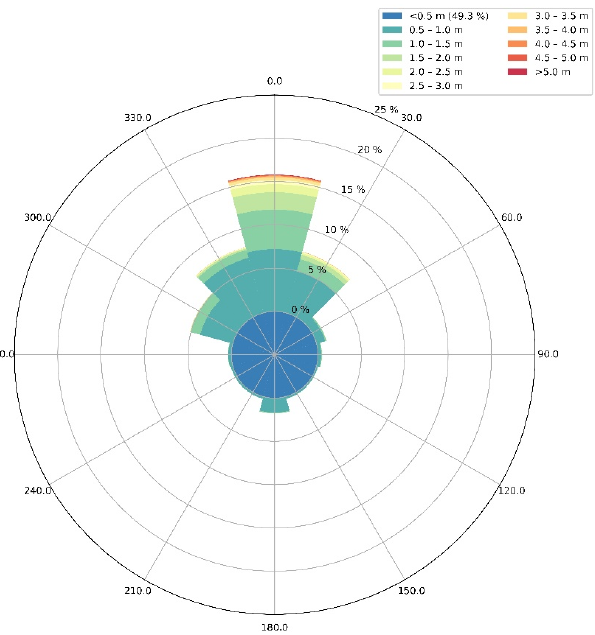
Figure 3. Wave Rose Diagram of Mean Annual Significant Wave Heights, Hs (m), offshore of the Rethymno area.